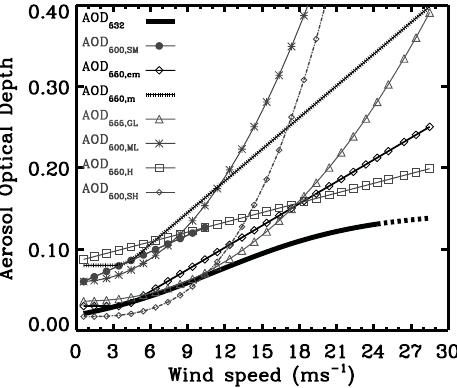
Fig. 6. Marine aerosol optical depth as a function of wind speed. The regression statistics and the acronyms are summarized in Ta- ble 1. See text for more